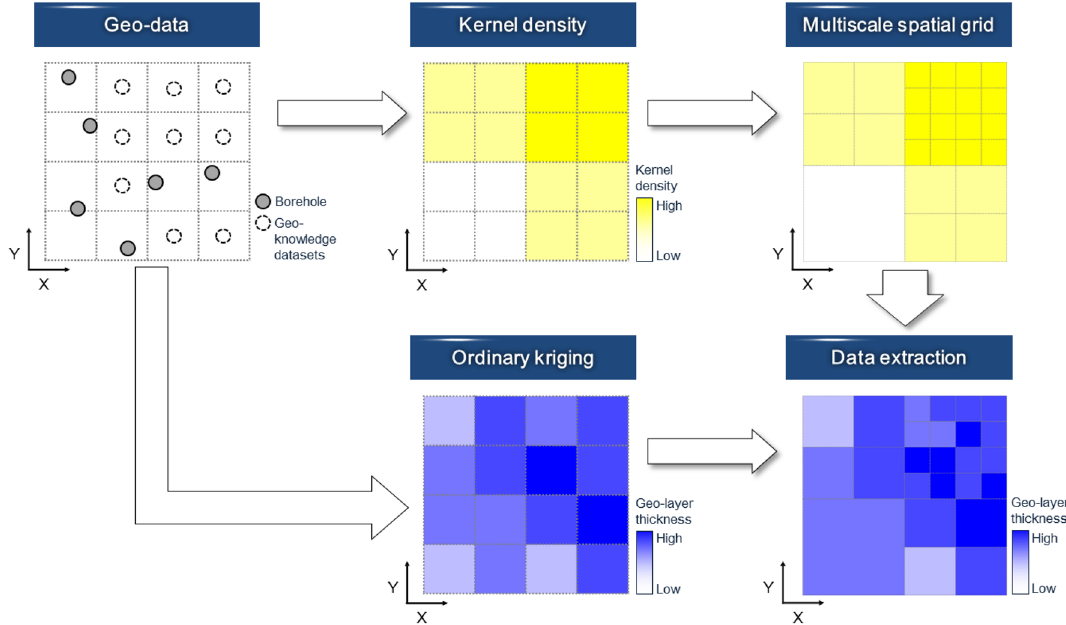
Fig. 3 Conceptual procedure for geostatistical spatial